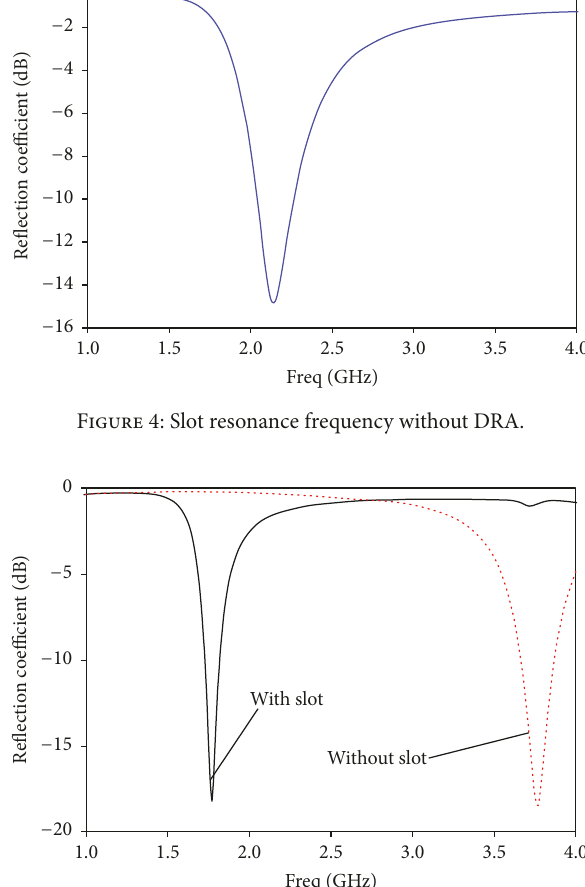
where 𝜀 DRA and 𝜀 air are the relative permittivities of DR element and air,